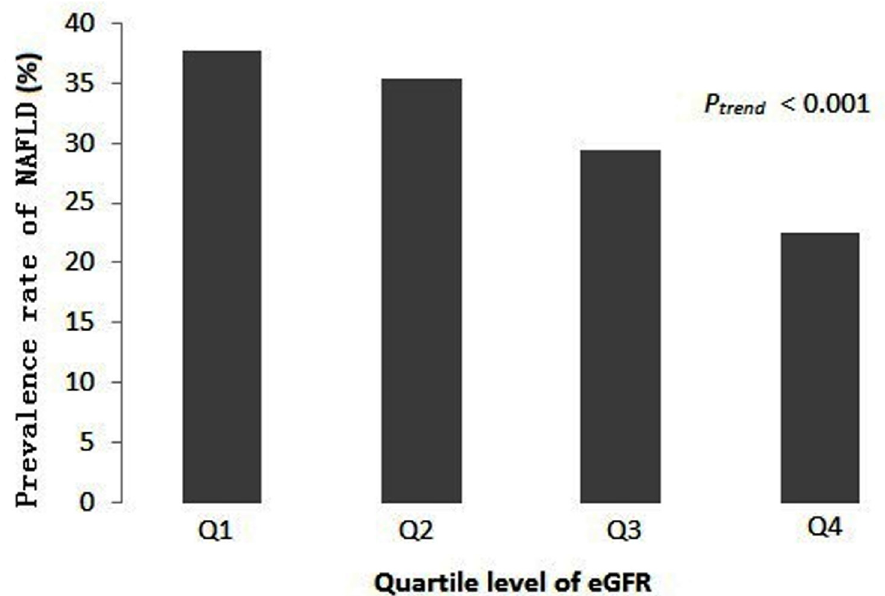
Fig 1. Comparison of relationships between eGFR and NAFLD in different age